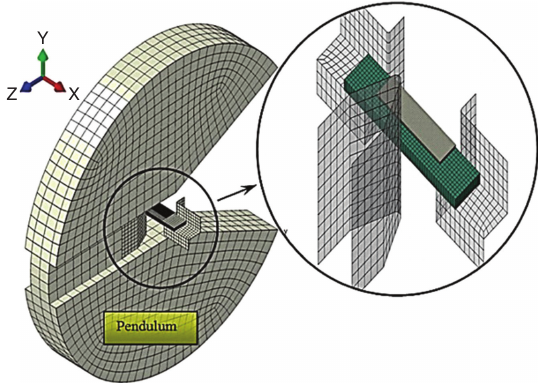
Figure 11 FE model for Charpy test rig.